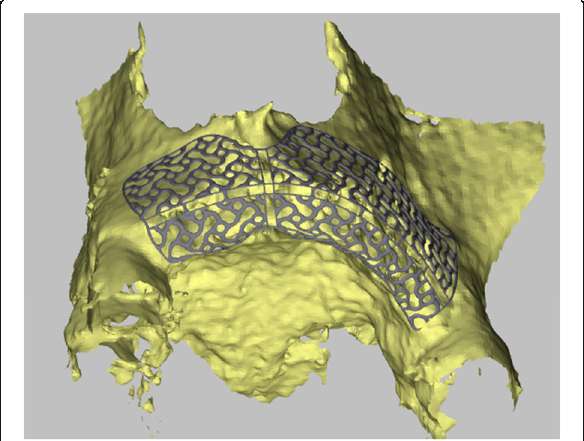
Fig. 3 3D design of the CAD-CAM-based individualized TM by ReOss® Fig. 4 Intraoperative clinical picture after insertion of CAD-CAM